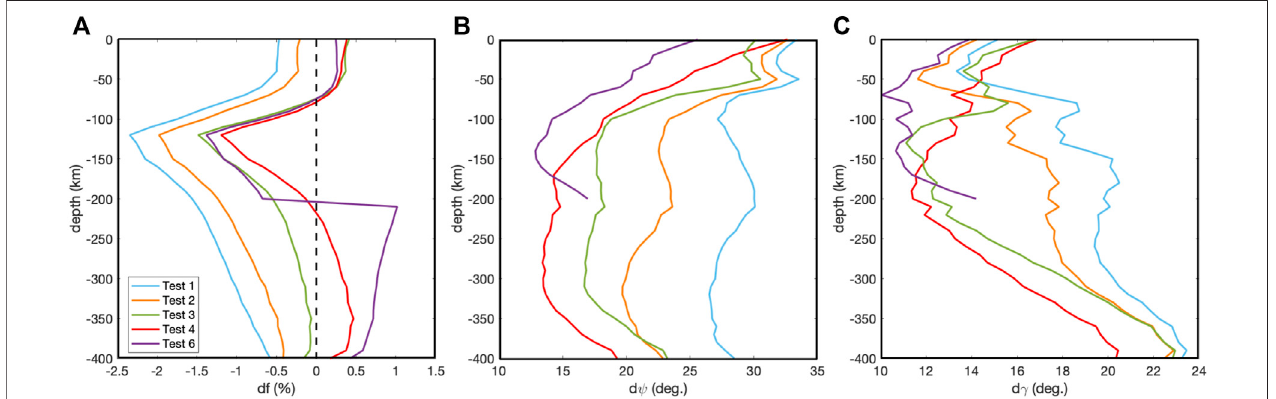
FIGURE10| Errorsinrecoveredanisotropicparameters.Meanerrorsintheanisotropic (A) fraction, (B) azimuth,and (C) elevationasafunctionofdepthareshown for Test 1 (blue line), Test 2 (orange line), Test 3 (green line), Test 4 (red line) and Test 6 (purple line).